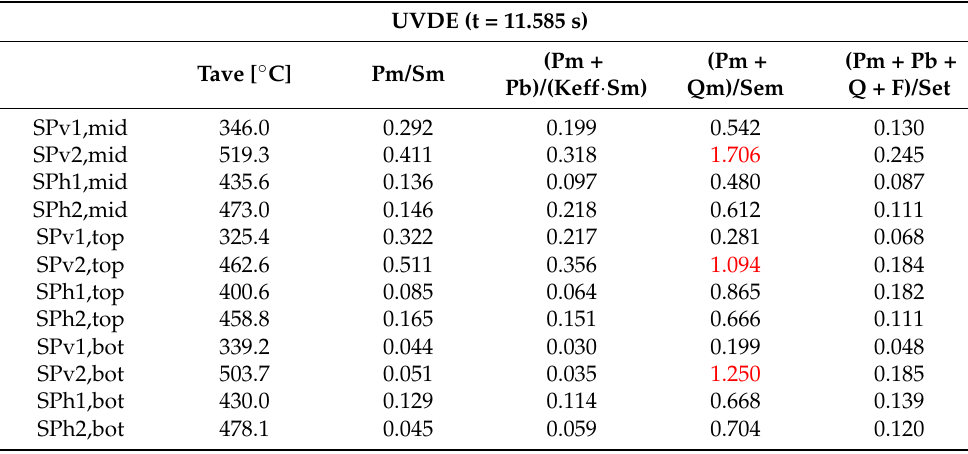
Table 9. Verification of RCC-MRx criteria under UVDE (t = 11.585 s) loading